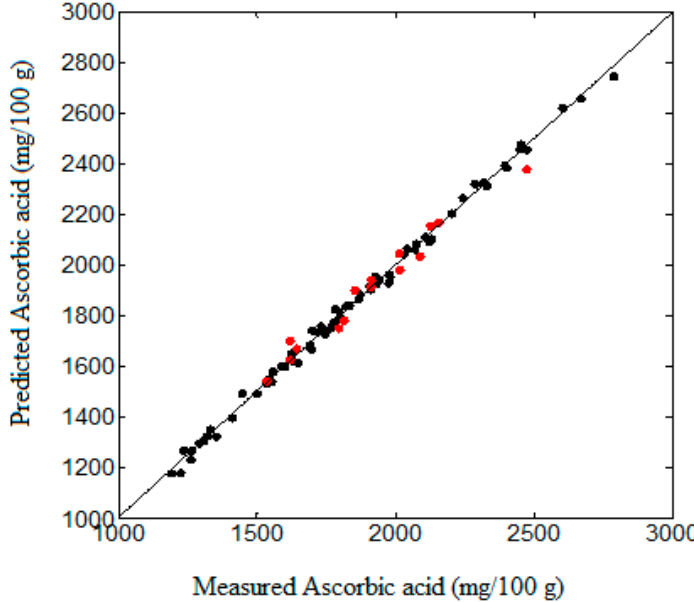
Figure 2. Measured versus predicted concentration of ascorbic acid (mg/100 g FW) in intact acerola using the genetic algorithm partial least squares (GA-PLS) model after second derivative pretreatment, where ( • ) calibration set; and ( • ) prediction set.